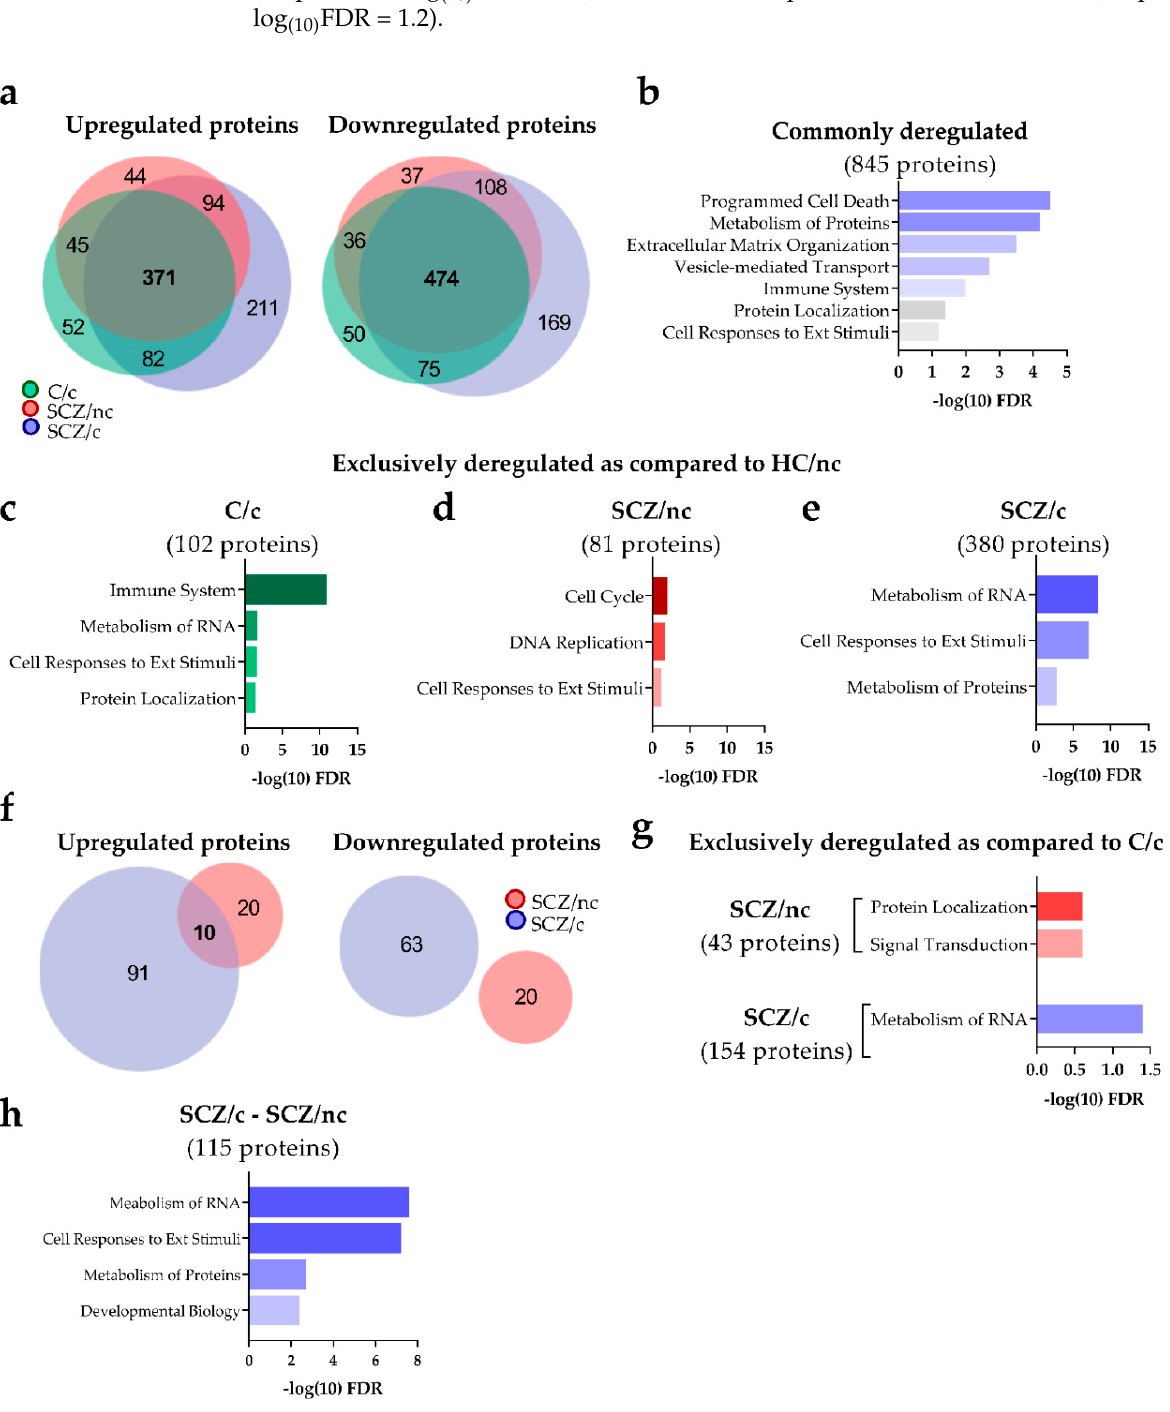
Figure 1. Characterization of the proteome of ON cells from control subjects non-cannabis users (C/nc), control cannabis users (C/c), schizophrenia patients non-cannabis users (SCZ/nc) and schizophrenia patients cannabis users (SCZ/c). ( a ) Proteomic alterations in C/c, SCZ/nc and SCZ/c as compared to C/nc. The upregulated and downregulated proteins in C/c-C/nc, SCZ/nc-C/nc and SCZ/c-C/nc are represented in two different Venn diagrams. ( b ) Enrichment pathway analysis of the 845 proteins commonly deregulated in C/c, SCZ/nc and SCZ/c as compared to C/nc. ( c ) Enrichment pathway analysis of the exclusively deregulated proteins in C/c, ( d ) SCZ/nc ( e ) and SCZ/c versus C/nc. ( f ) Proteomic alterations in SCZ/nc and SCZ/c as compared to C/c. The upregulated and downregulated proteins when SCZ/nc-C/c and SCZ/c-C/c are compared are represented in two Venn diagrams. ( g ) Functional characterization of the 43 proteins deregulated in SCZ/nc and the 154 proteins deregulated in SCZ/c as compared to C/c. ( h ) Functional characterization of the 115 proteins deregulated in SCZ/c as compared to SCZ/nc. Data from the pathway analysis are represented as minus the logarithm (10) of the FDR.